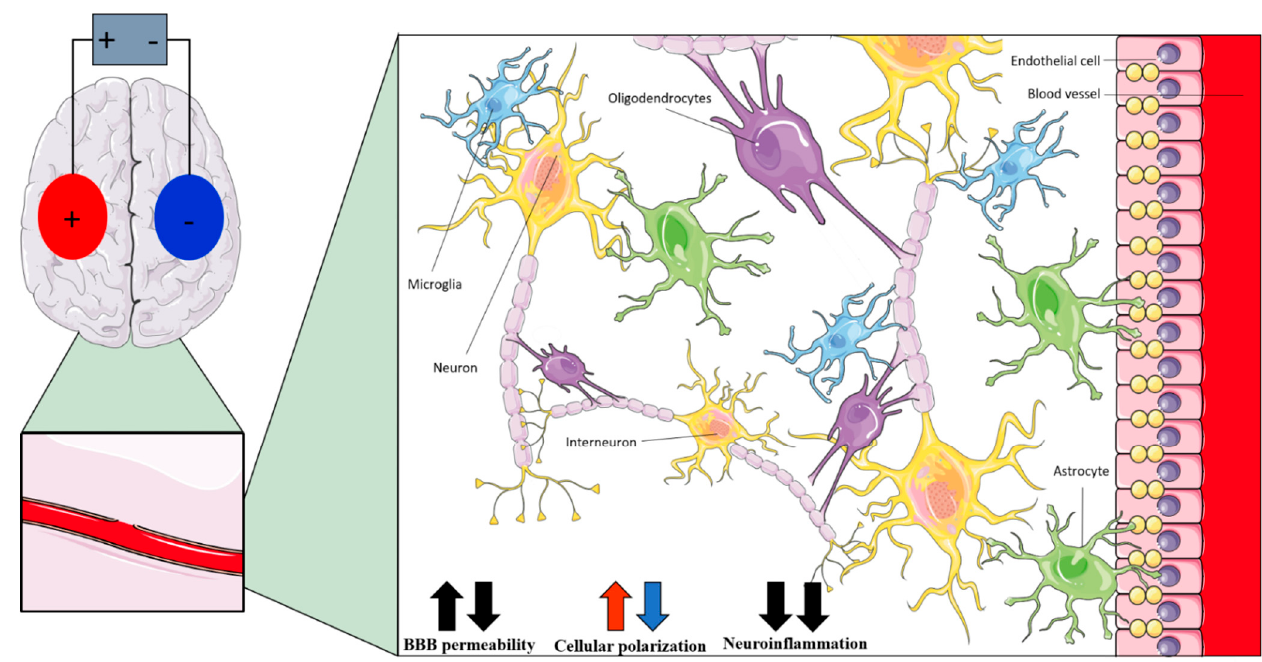
Figure 4. Representation (“+” is anode; “ − “ is cathode) of the presumed in vivo effects of transcranial electrical stimulation on non ‐ neural components of the brain at intensities applied in human proto ‐